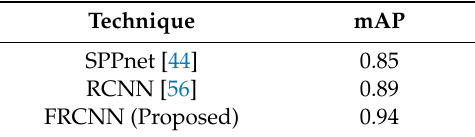
Table 3. Performance comparison of the presented technique with other